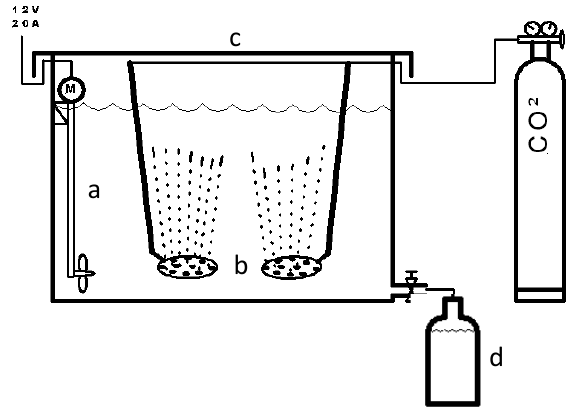
Fig. 6. Schematic drawing of the setup used for the preparation of CO 2 -enriched water. An electric outboard motor (a) continuously mixed the water in the 1.4m 3 polypropylene tank which was tightly closed by a lid (c) . Two large aerating disks (b) produced fine bub- bles ensuring relatively low gas consumption. After aeration, the CO 2 -enriched water was filled into 25L polycarbonate carboys (d) for transport and quantitative addition into the mesocosms, using the “spider”.